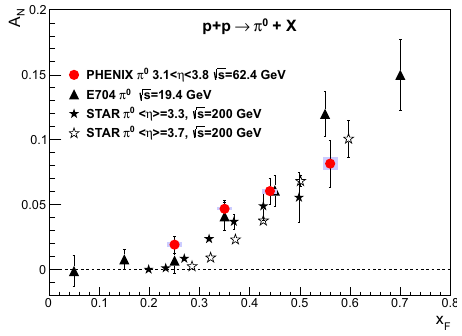
√ s dependence of large- x F neutral